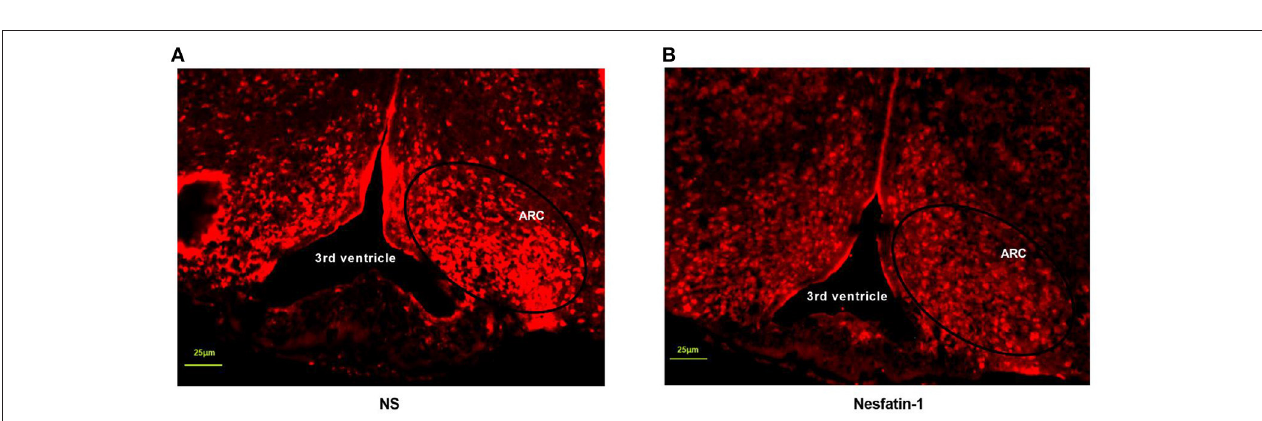
FIGURE 8 | Nesfatin-1 inhibited c-fos expression induced by fasting in arcuate nucleus. GHSR + / + mice were treated with tail vein injection of vehicle and nesfatin-1 after 12h fasting . (A) C-fos expression in hypothalamic ARC of mice injected with vehicle. (B) C-fos expression in hypothalamic ARC of mice injected with nesfatin-1. N =